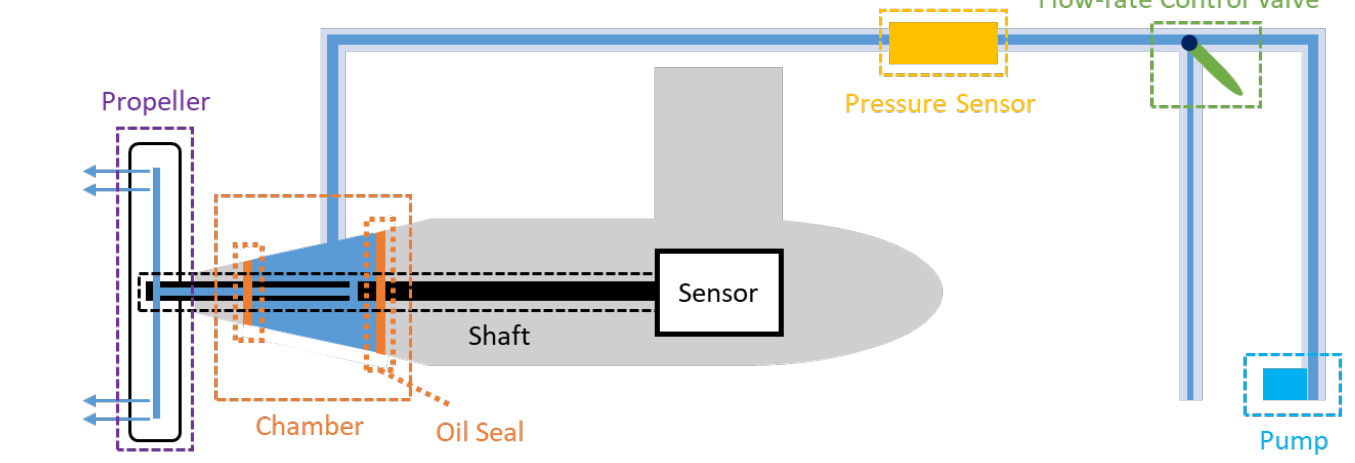
Figure 3. Diagram of the experimental setup.